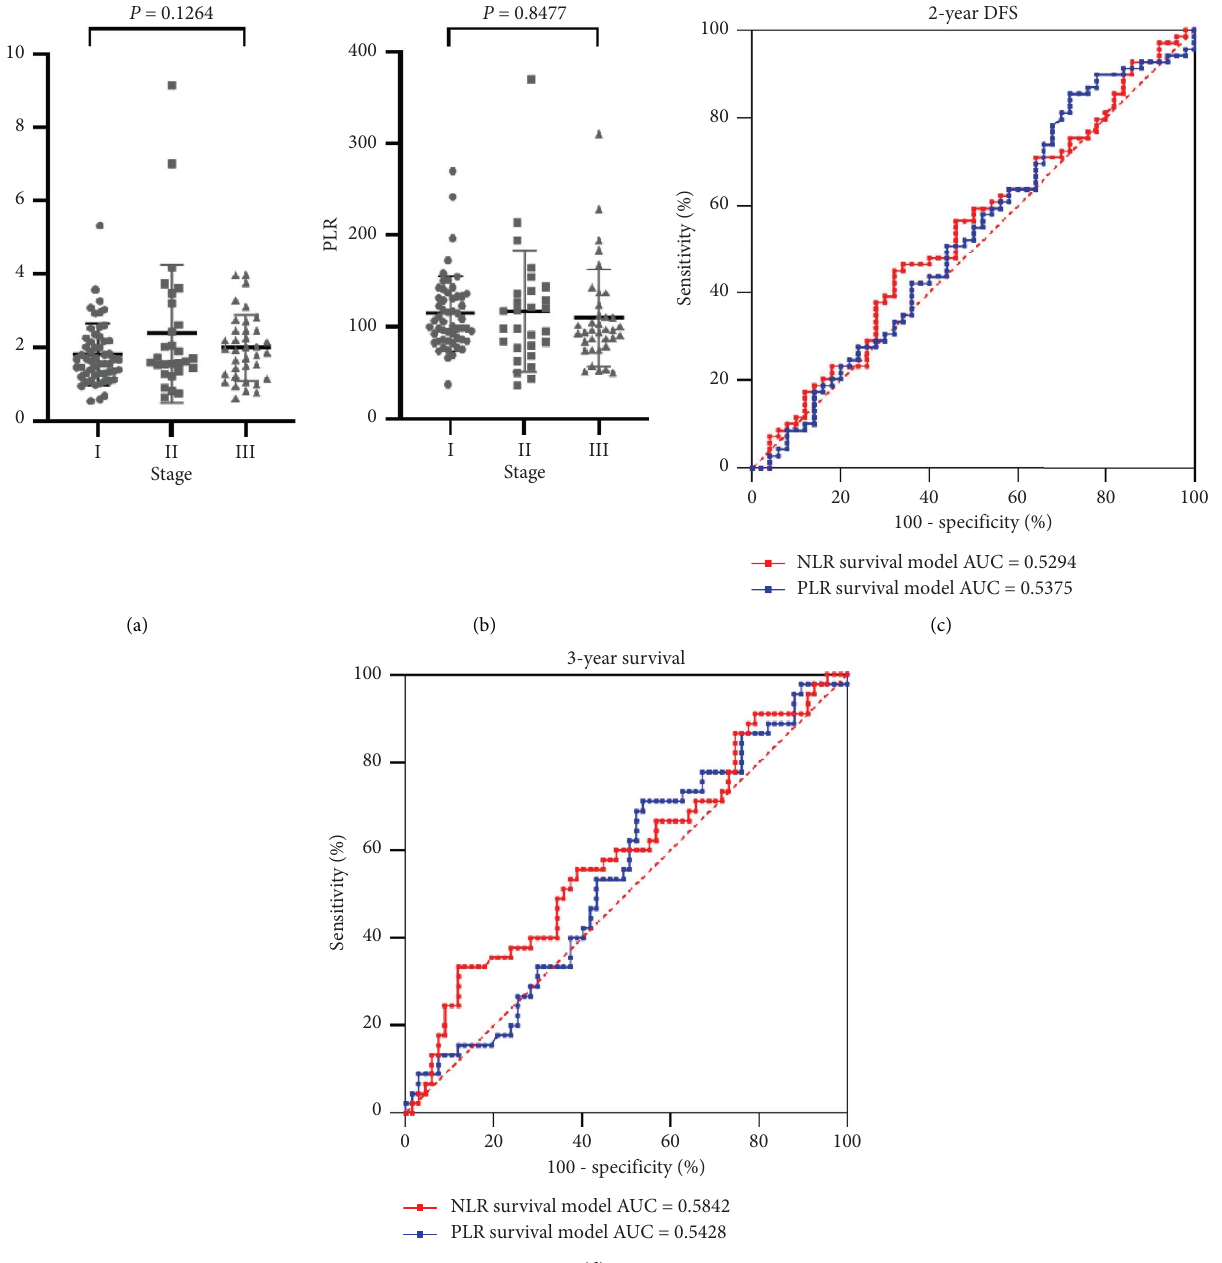
Figure 5: Correlations between the preoperative NLR, PLR, and TNM stage, and the prognosis of resected SCLC patients. (a) Te preoperative NLRs of resected LS SCLC patients by the TNM stage. (b) Te preoperative PLRs of resected LS SCLC patients by the TNM stage. (c) Te 2-year DFS predictions of the receiver operator curves for NLR and PLR ( n � 119). (d) Te 3-year OS predictions of the receiver operator curves for the NLR and PLR ( n �